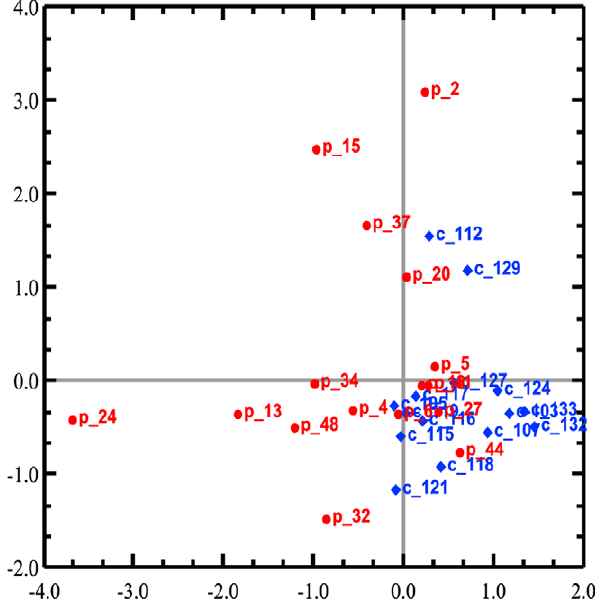
Figure 1. Correspondence analysis showing projection of samples. Patients with primary hyperparathyroidism are shown with red dots and the control group are shown with blue squares. The first principal component shows the largest variance in the dataset with 8.83% and the second principal component represents the second largest variance with 6.69%. Patients with primary hyperparathyroidism are separated from the control group along both axes.